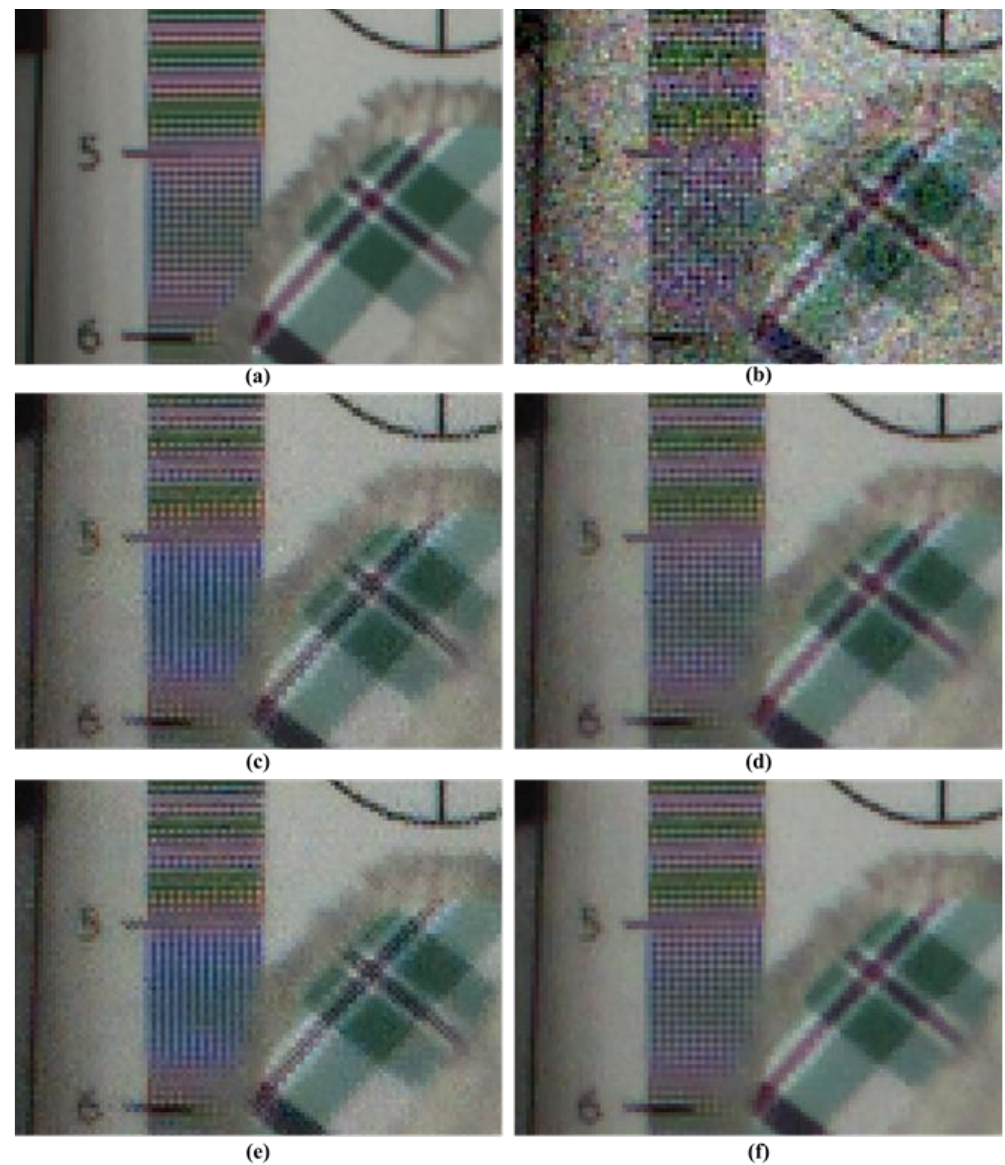
Figure 10. Partially magnified the Moving train sequence. ( a ) Original image; ( b ) Color demosaiced image obtained by [15] for noisy image with σ = 10 of Bayer pattern; ( c ) Denoised image by method [31] with demosaicing of [15]; ( d ) Denoised image by method [9] with demosaicing of [15]; ( e ) Denoised image by method [32]; ( f ) Denoised image by proposed method with demosaicing of [15].